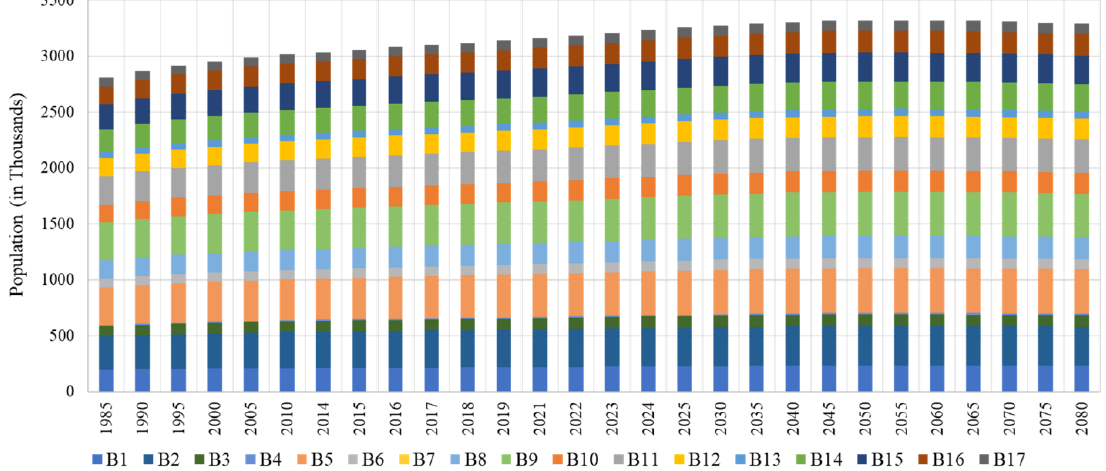
Figure 4. Observed (1985–2014) and projected (2015–2080) population in 17 sub ‐ basins of the SRB.